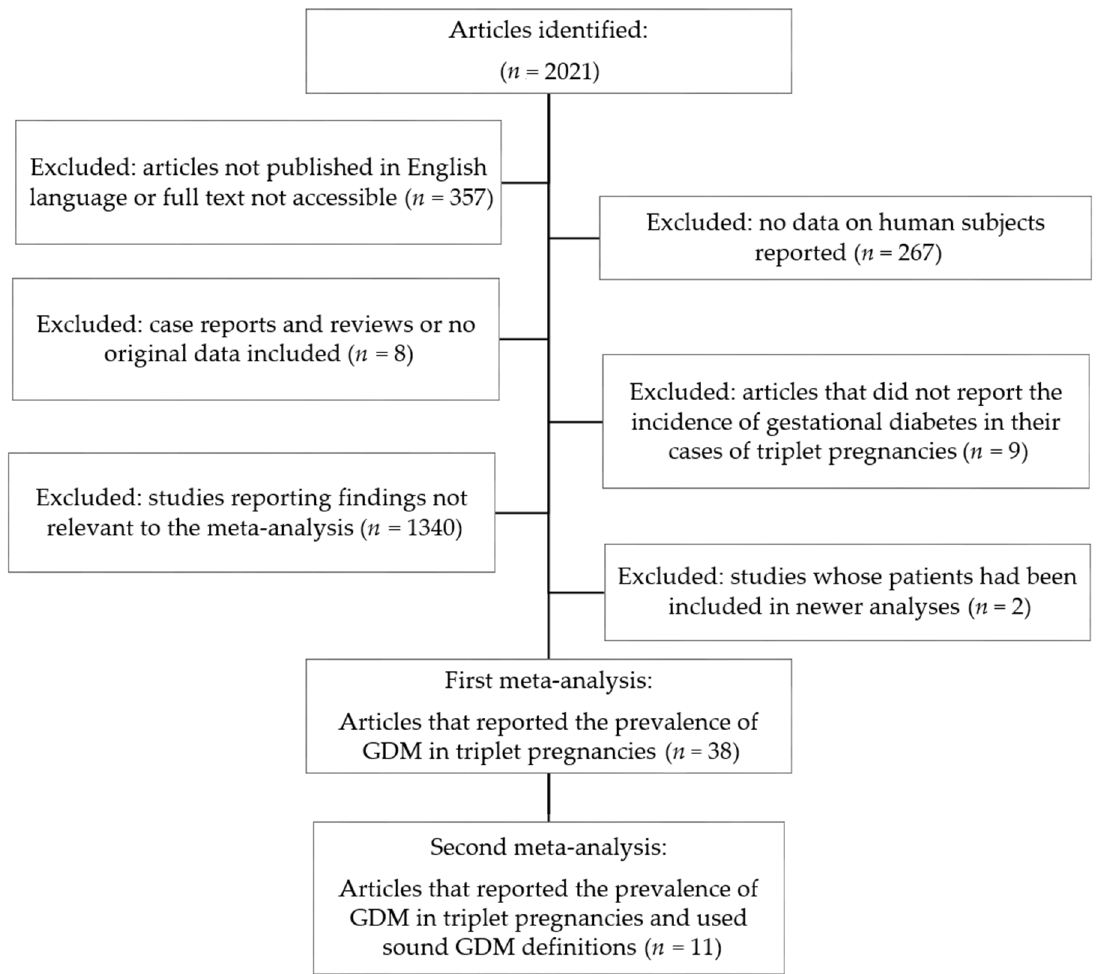
Figure 1. Flow chart for the meta-analysis. GDM, gestational diabetes mellitus.